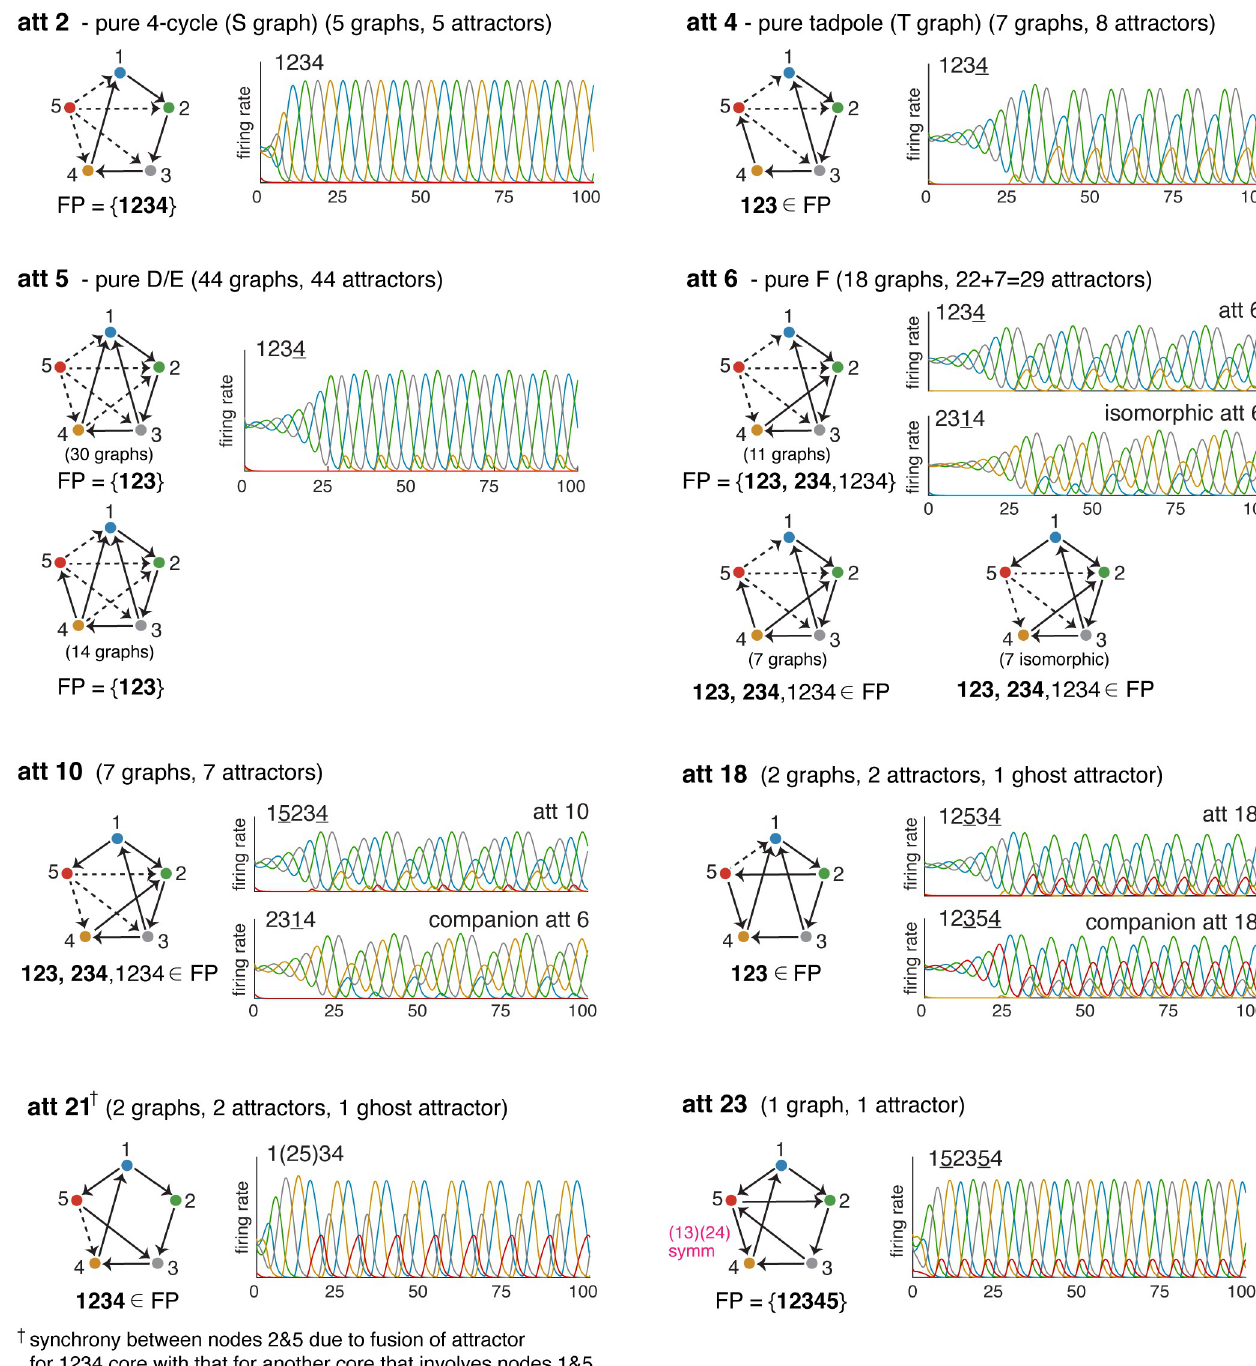
Fig 7. Attractor classes and master graphs. A sampling of attractor classes from the full classification for n = 5 oriented graphs with no sinks. Each attractor emerges from multiple graphs which, once properly aligned, fit neatly into families that can be summarized by “master graphs” with optional edges depicted via dashed lines. For families where FP( G ) is invariant across all graphs, the full form is shown. Otherwise, only the common fixed point supports are given. Some families always have two attractors: in these cases, the secondary attractor is shown as a “companion attractor” next to the relevant master graph. Note that the graph for att 23 has an automorphism, shown in pink. The full classification and further details of our notational conventions are provided in the Supporting Information.